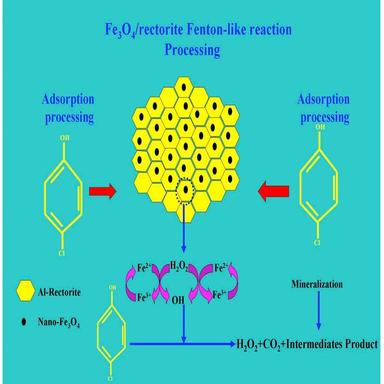
Schematic of the reaction mechanism of H2O2 activation by Fe3O4/rectorite catalyst under acidic condition.